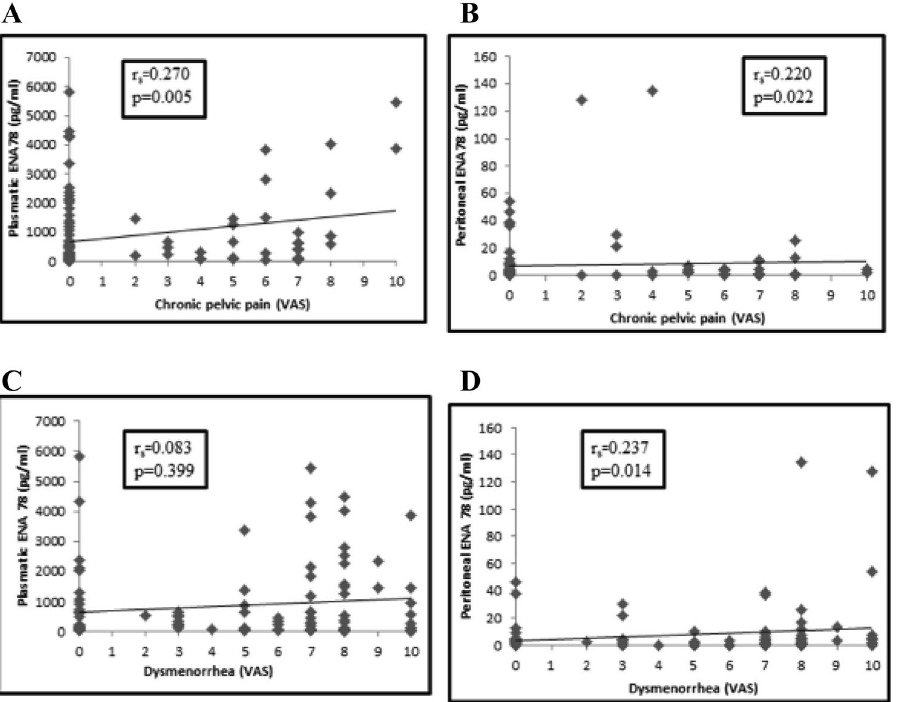
Figure 1. Correlation between the concentration of ENA 78 in plasmatic (A) and peritoneal (B) fluid and severity of chronic pelvic pain (VAS score). Correlation between the concentration of ENA 78 in plasmatic (C) and peritoneal (D) fluid and severity of dysmennorhea (VAS score). In the inset Sperman’s rank correlation coeficient (rs) and p value.